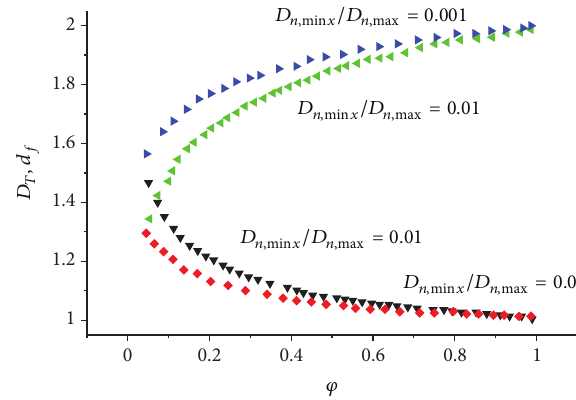
Figure 5: The relationship among 𝜙 , 𝐷 𝑇 , and 𝑑 𝑓